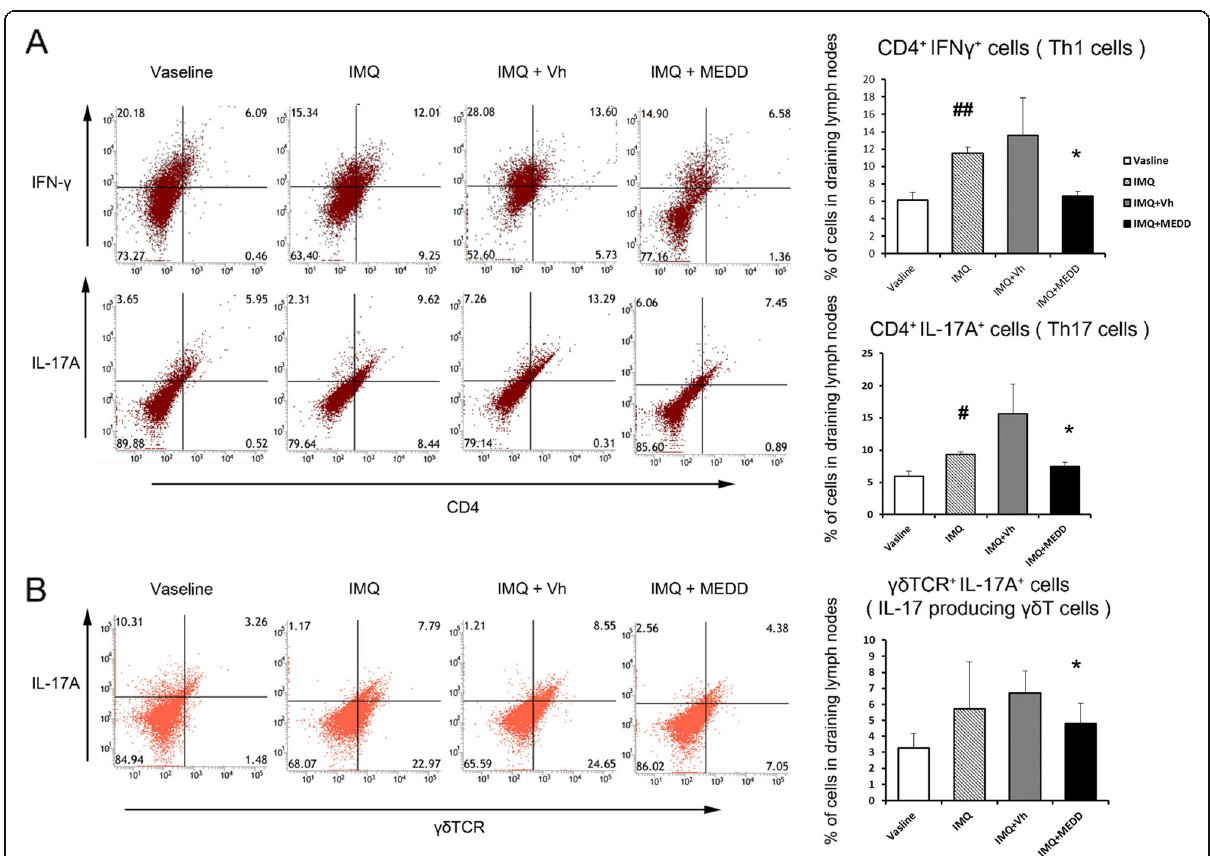
Fig. 3 Effect of MEDD on immune cell population in IMQ-induced psoriasisThe dorsal skin of mice was treated with Vaseline, IMQ, IMQ and Vh or MEDD for 7 days, and the immune cell population was analyzed by flow cytometry in the skin draining lymph nodes the next day. a CD4 + IFN γ + Th1 and CD4 + IL-17A + Th17 cell populations were analyzed. (left) Representative dot blot and (right) quantified percentage of Th1 and Th17 cells. b IL-17A + γδ TCR + (IL-17 producing γδ T cells) cell populations were analyzed. (left) Representative dot blot and (right) quantified percentage of IL- 17-producing γδ T cells. These results represent the mean ± S.D. of four independent experiments. Statistical analysis was performed using Student ’ s t -test. * p < 0.05, compared with mice in the IMQ- and vehicle-treated group; #, p < 0.05; ##, p < 0.01 compared with Vaseline control mice; IMQ, imiquimod; Vh, Vehicle; MEDD, methanol extract of Dictamnus dasycarpus root